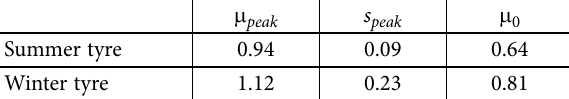
Figure 17. Adhesion characteristics m ( s ) for summer and winter tyres (ambient temperature –15 ° C, tyre producer 2) Table 7. Differences in slip referring to m peak adhesion coefficient (tyre producer 1, wet surface, v = 60 km/h, T = –15 ° C)